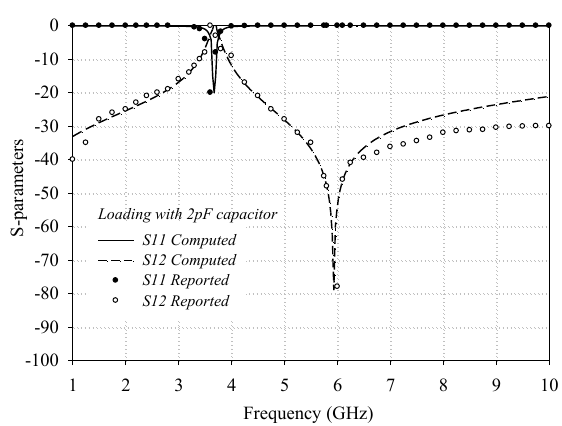
Figure 4. S-parameters loaded FSS with SIW. Solid line show computed result at dept. of ECE, NITT. Bubbles show reported results from figure 2